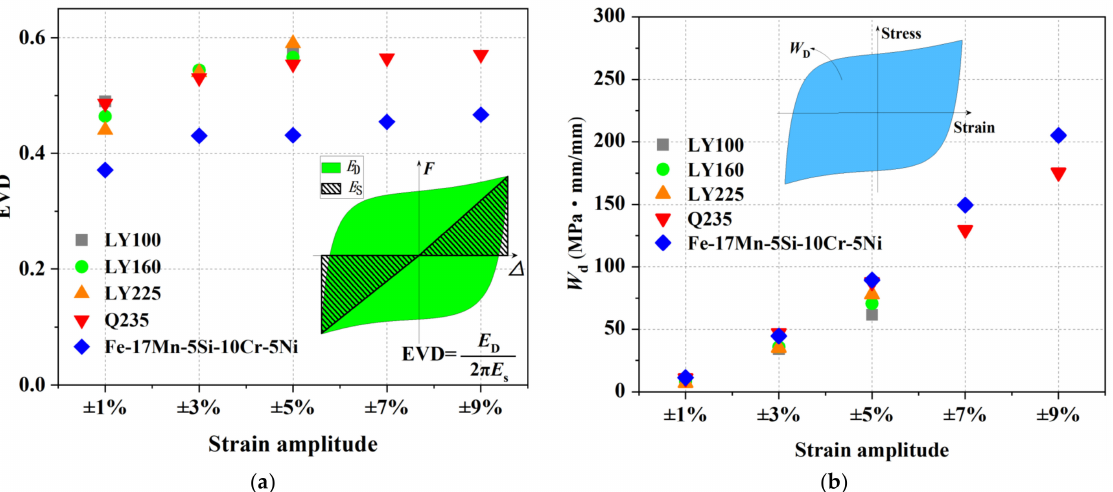
Figure 12. Parameters for evaluating energy dissipation capacity under different strain amplitudes: ( a ) EVDs; and ( b ) Absolute energy dissipation at half-life cycle. Results are re-produced from